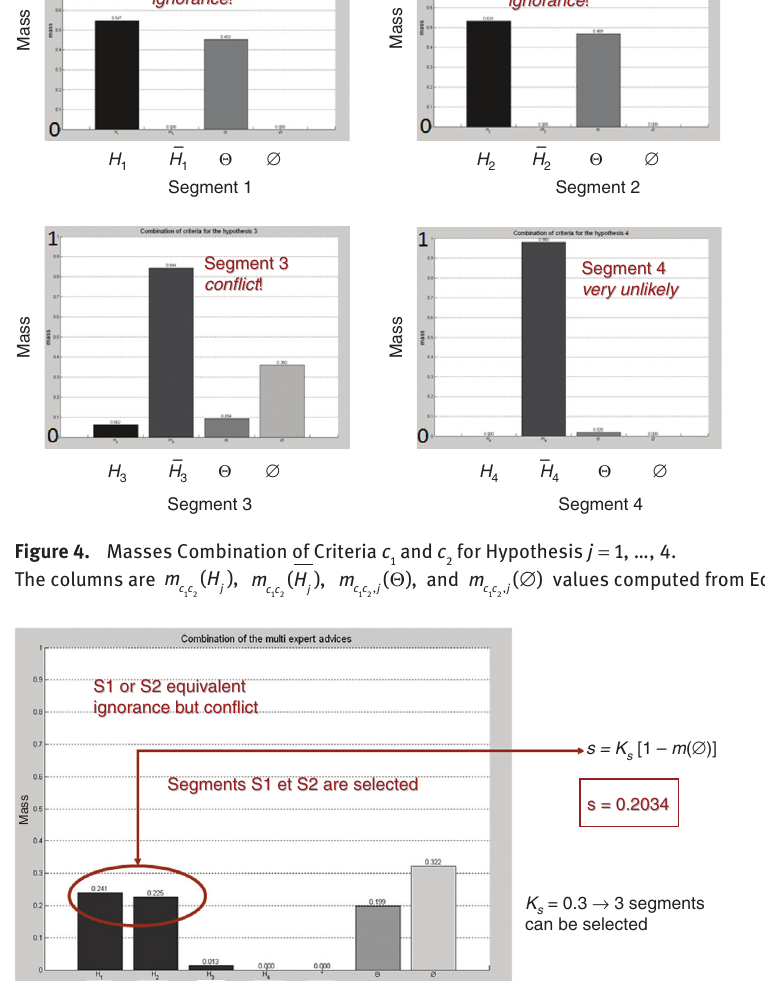
( H ) for j = 1, …, 4, m · j